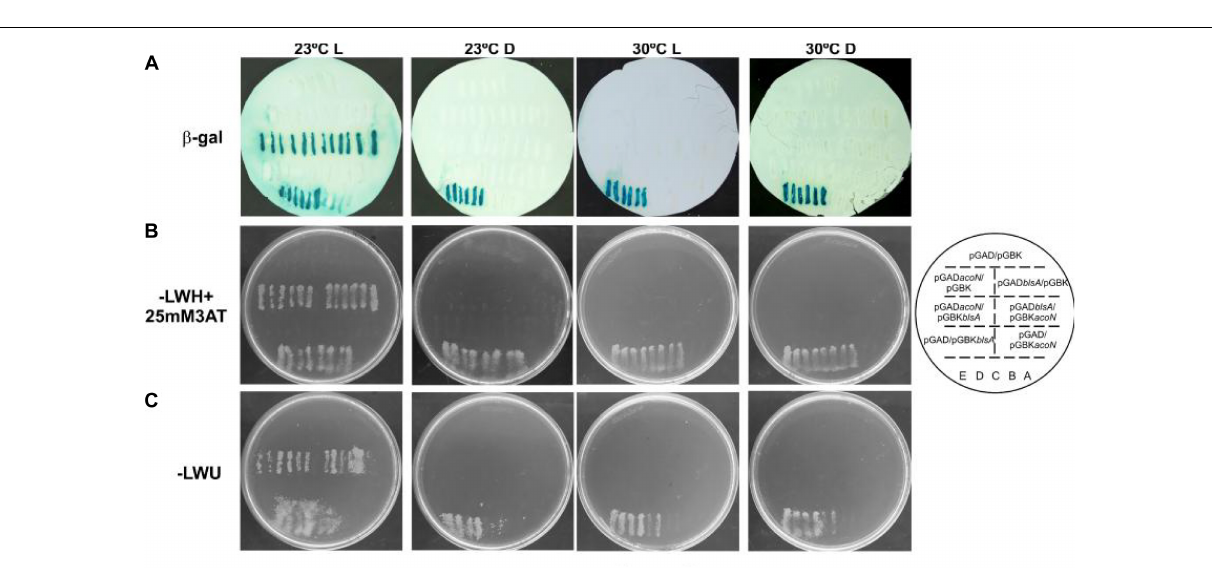
FIGURE 6 | BlsA interacts with AcoN only under blue light at moderate temperatures in A. baumannii . BlsA–AcoN interaction was analyzed by Y2H assays at different conditions including 23 ◦ C under blue light (L) or in the dark (D), and 30 ◦ C under blue light (L) or in the dark, following procedures described in Cribb and Serra (2009) and Tuttobene et al. (2018). In each plate were patched six clones of MaV203/pGAD- blsA or MaV203/pGAD- acoN transformed with plasmids pGBK- acoN or pGBK- blsA , respectively, as well as plasmid pGBK-T7 as negative control. Reciprocal combinations were also included, as well as self-activation and different strength interaction controls (strains A–E). The scheme on the right side represents the order of yeast streaks on each plate. Panel A shows results for the lacZ reporter, panel B for the histidine auxothropic reporter and panel C for the uracil reporter. Experiments were performed in triplicates and representative results are